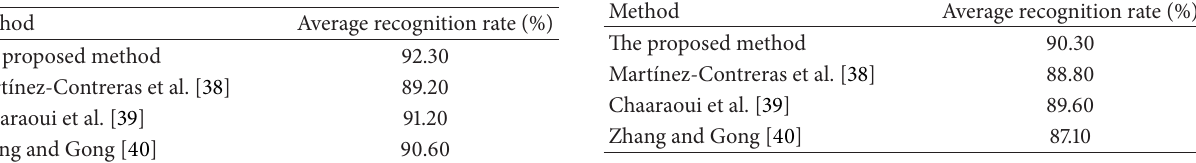
Table 8: Comparison with other approaches on our action